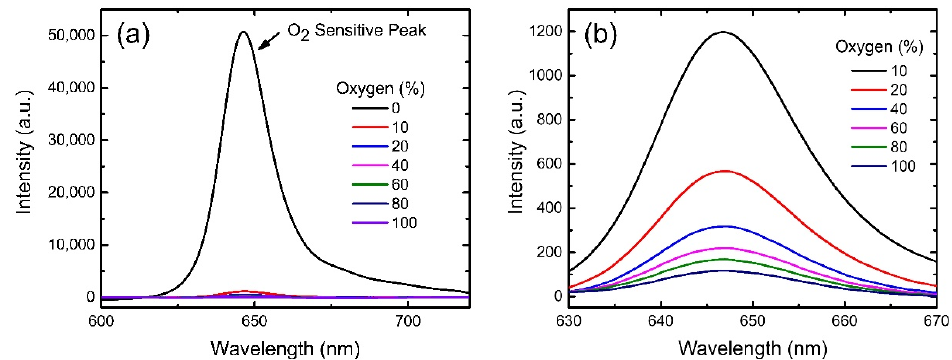
Figure 7. ( a ) Emission spectra of PtOEP molecules on AAO membrane with different oxygen concentrations from 0–100%. ( b ) Enlarged spectra from ( a ) for better visualization. To quantitatively address the sensitivity of the proposed sensor, the response vs gas concentrations for the two cases was plotted as shown in Figure 8. The response of the AAO case shows linearly increasing trend at low oxygen concentrations and then in- creases rapidly at higher ones deviating from the linearity. Figure 8 also implies that AAO- based sensor is much more sensitive to oxygen concentration while comparing with the glass-based one. We fitted the data points with the non-linear Stern-Volmer equation (Equation 2) as displayed by the solid lines in Figure 8. The good fittings of non-linear Stern-Volmer equation suggests that the static and dynamic quenching behaviors coexist in both sensors. The K S and K D values extracted from the fittings are 3.7% − 1 and 0.003% − 1 for the AAO case and 0.86% − 1 and 0.002% − 1 for the glass one, respectively. Note that the K D values of both the AAO- and glass- based sensors are insignificant compared to the K S values insinuating the predominance of static quenching over dynamic one in both cases. In addition, the K S value of the AAO case is 4 times larger than that of the glass one, de- picting the extraordinarily higher sensitivity of AAO-based sensors. Interestingly, the re- sponse of the AAO-based sensor (~500) at the oxygen concentration of 100% is nearly 5 times higher compared to that (~110) of the glass-based sensor. This is the highest response hitherto achieved by PtOEP based oxygen sensor to the best of our knowledge (Table 1). Figure 8. Responses as functions of oxygen concentrations for PtOEP-based oxygen sensors by using AAO membranes (pink squares) and glass substrates (blue dots). Equation 2 is used to fit the data